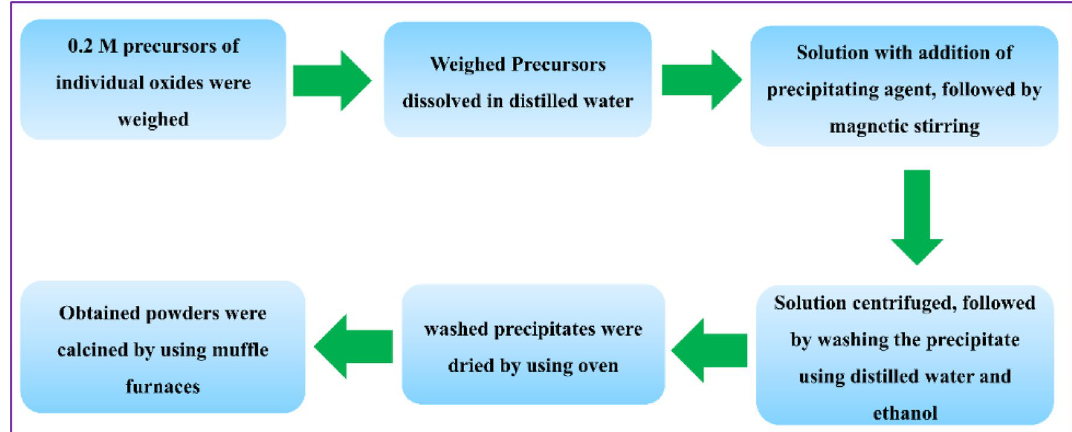
Fig. 1 Flow chart of synthesis procedures of individual metallic